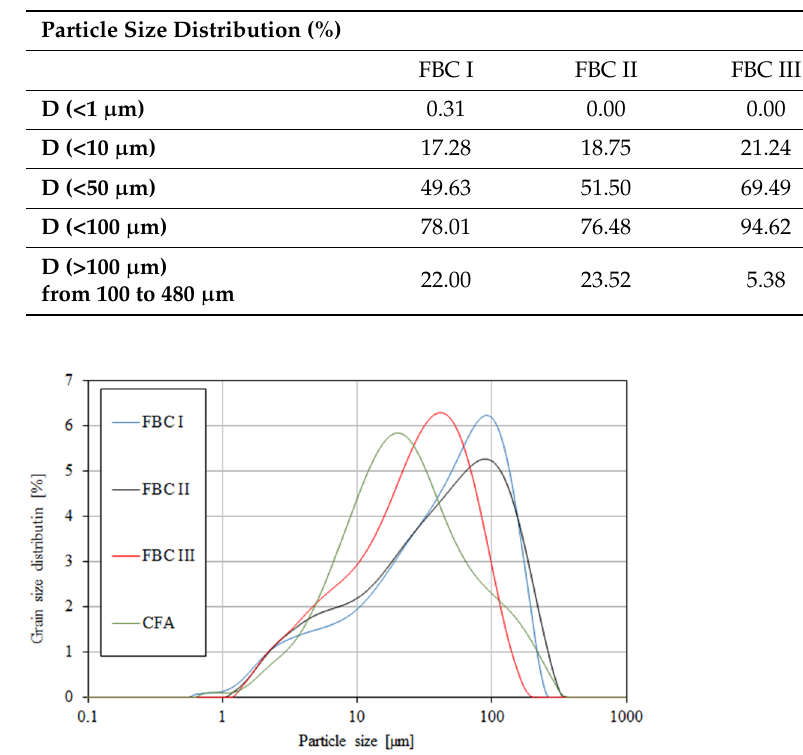
Table 3. Particle size distribution of fluidized fly ash (FBC I, FBC II, FBC III) and conventional fly ash (CFA).